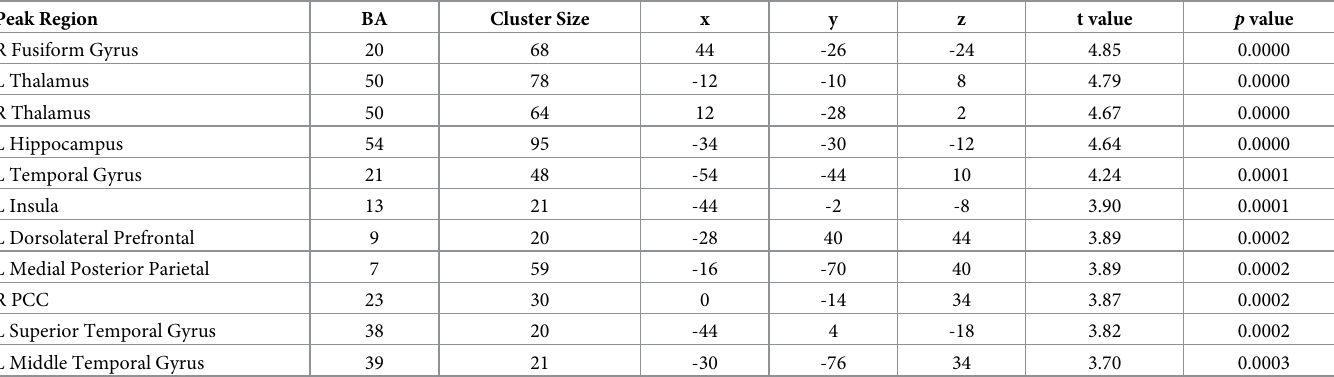
Table 5. Local maxima of brain activation (2-Back– 0-Back): Group-by-time interaction. Peak